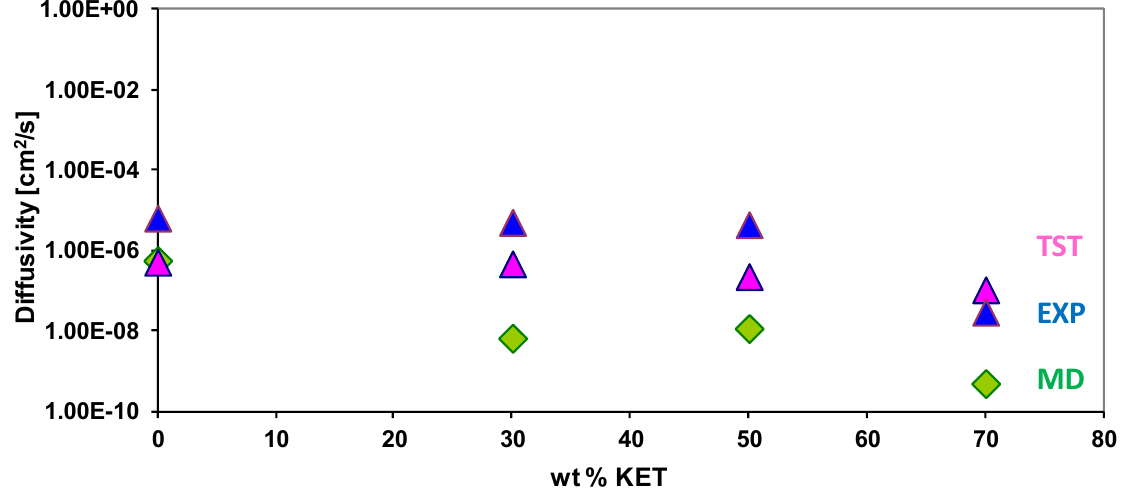
O in PEBAX membrane with 2